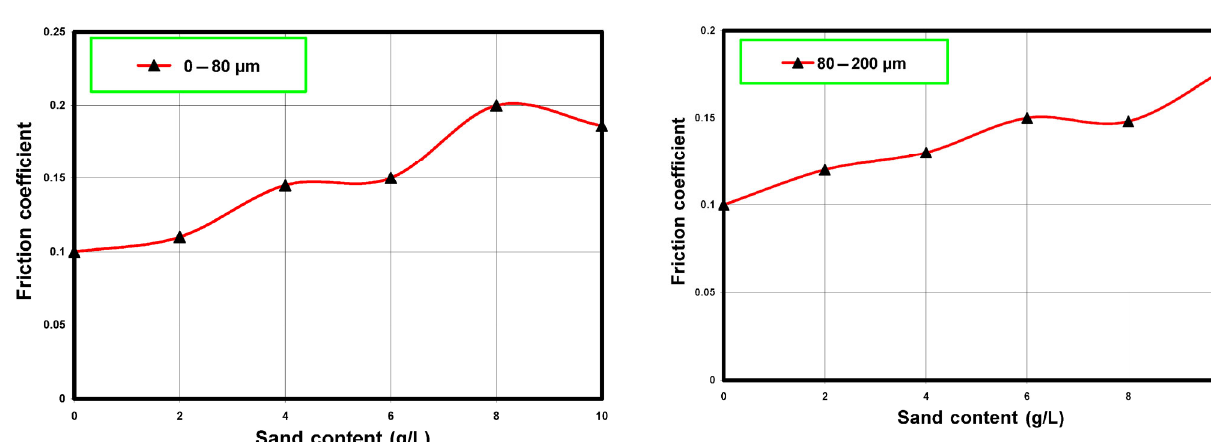
Fig. 6 Effect of sand contamination in lubricant on friction for sand particles of size 80–200 µm.